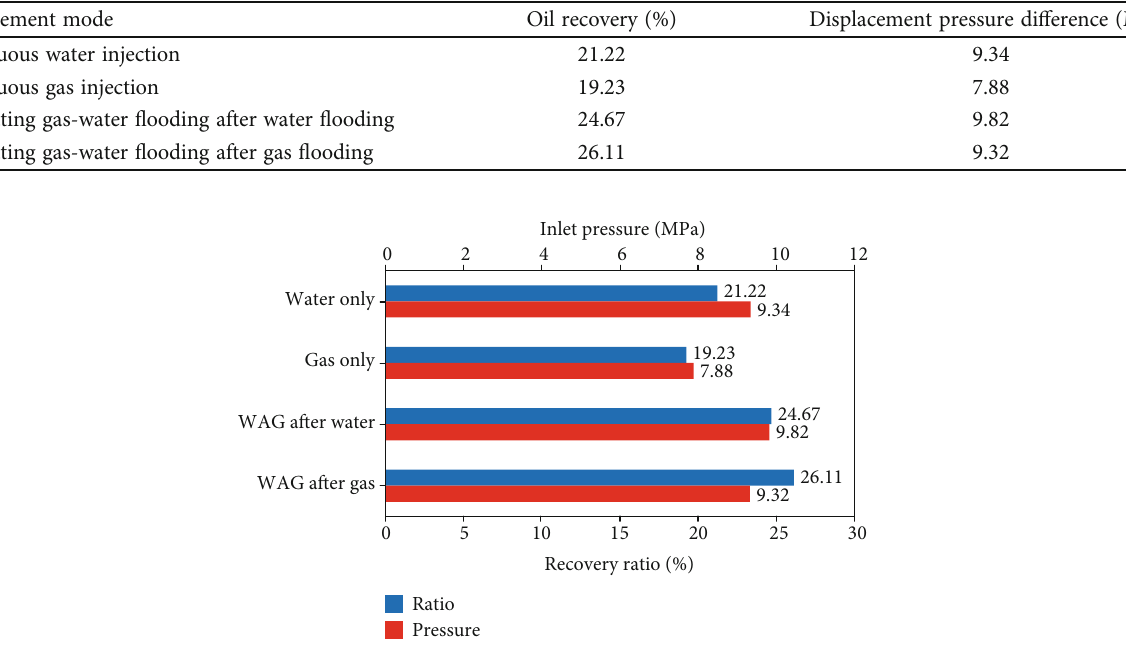
Figure 9: Comparison of oil displacement experimental results under di ff erent displacement modes. Table 3: Orthogonal experimental scheme design table of alternating gas-water fl